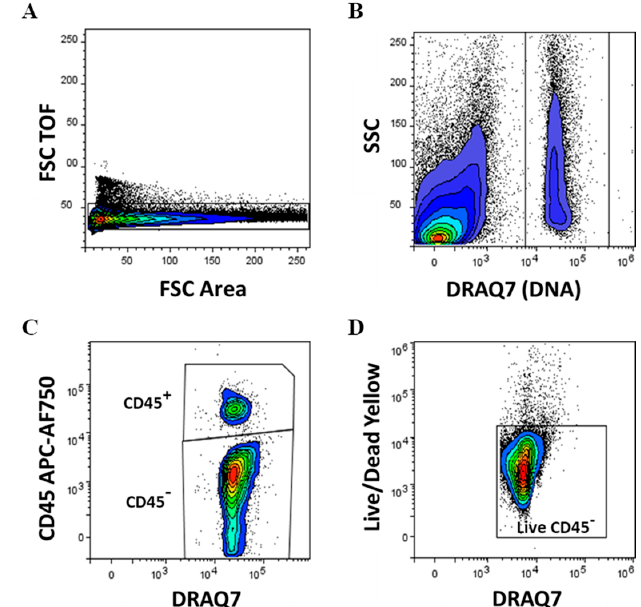
Figure 1. Gating strategy, expression of the CD45 cell surface marker and cell viability in stromal vascular fraction (SVF) cells obtained from lipoaspirate (SVF-LA) or its microfragmented lipoaspirate (SVF-MLA) counterpart. Singlet cell selection was performed on forward scatter (FCS) time of flight (TOF) and FSC area signals density plot ( A ). Only events from nucleated cells were analyzed further, based on the DNA-binding DRAQ7 dye-positivity and side scatter (SSC) ( B ). Nucleated CD45 + and CD45 - cells were discerned ( C ), and live CD45 - cells ( D ) and CD45 + cells determined.